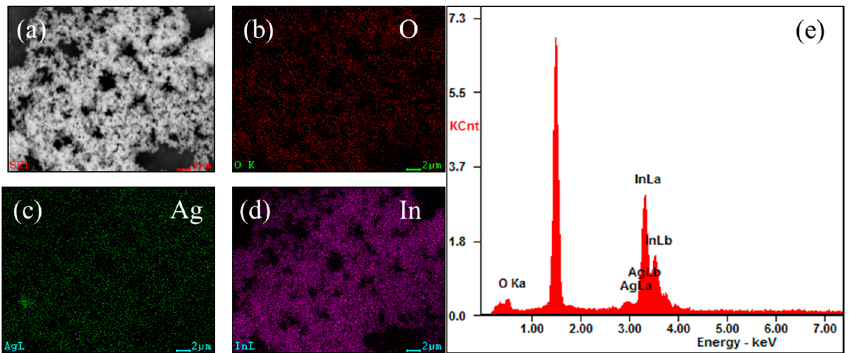
2 O 3 nanomaterials.